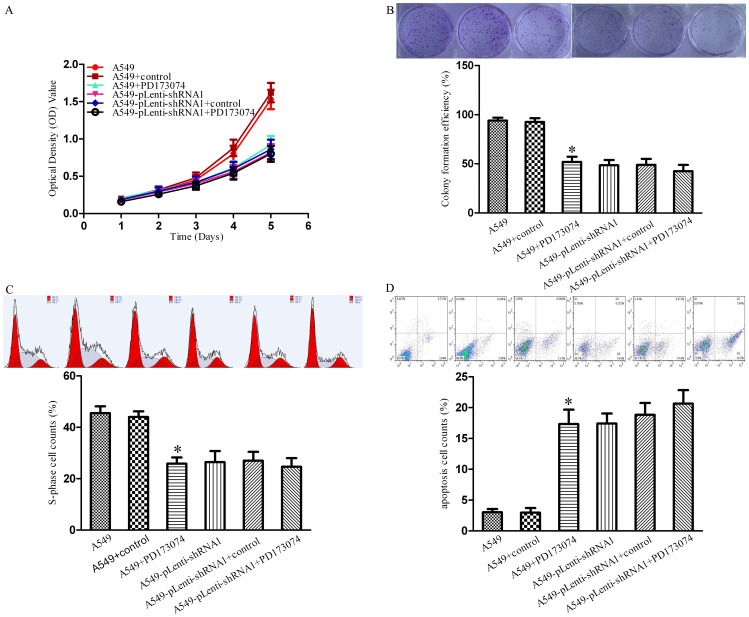
PD173074 inhibition of cell proliferation, cycle transition, and apoptosis resistance depends on the TC-1 expression level in vitro.(A) MTT assay. The optical density value was detected at a series of time points to evaluate cell proliferation. (B) Plate colony formation assay. The colonies were stained with crystal violet staining solution and counted, and the clone formation rate was then calculated. (C) Cell cycle assay. The percentage of cells in the S phase was measured using a flow cytometer, and the data were analyzed using the ModFit LT software. (D) Cell apoptosis assay. The cells were incubated in the dark in a solution containing PE-A and PerCP-Cy5.5. The percentage of apoptotic cells (lower right quadrant) were analyzed using a FACS equipped with a doublet discriminating module, and the data were analyzed using the CellQuest software. The columns represent the average colony formation rate (B), S-phase cell rate (C), and apoptosis cell rate (D) from at least three independent experiments. The bars show the SE. *indicates statistically significant changes (P<0.05) between the A549 group and the A549+PD173074 group.